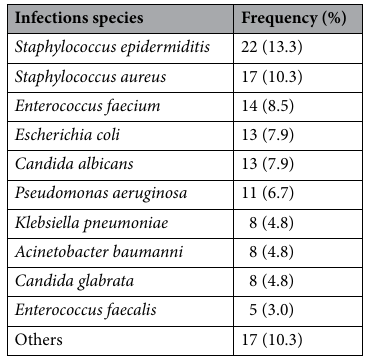
Table 2. Frequency distribution of different bacteria in culture-positive results as the cause of infection. Data are presented as n (%).